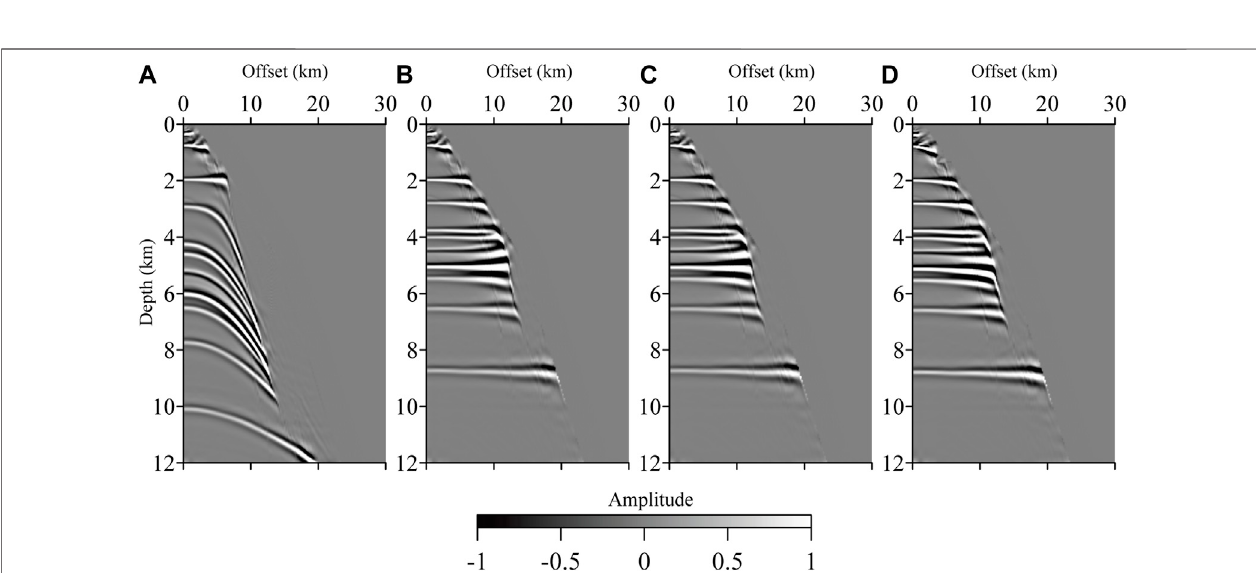
FIGURE 13 | CIG pro fi les at a distance of 50 km. (A – D) corresponds to (A – D) in Figure 12 , respectively.